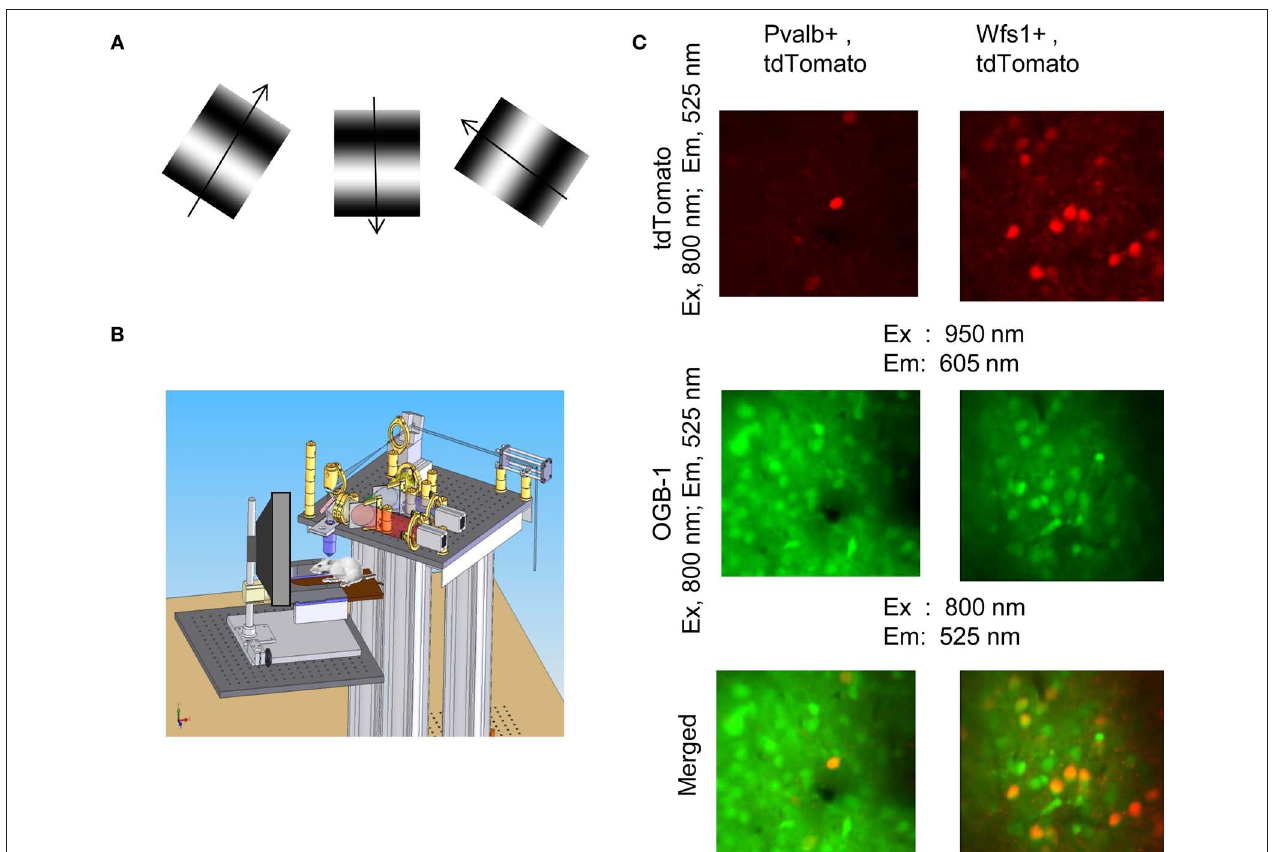
chamber holder (not shown). This allows the head of the mouse to be fixed directly in front of the monitor with the craniotomy directly under the objective of the two-photon microscope. (C) Left column for Pvalb ( + )/tdTomato( + ) cells and right column for Wfs1 ( + )/tdTomato ( + ) cells in the layer 2/3. TdTomato cells are visible when the cortex is excited by 950 nm two-photon laser and emission acquired through a 605 ± 35 nm filter. OGB-1 filled cell soma can be visualized at 800 nm excitation and 525 ± 25 nm emission. The last image in both columns is the merged red and green channel